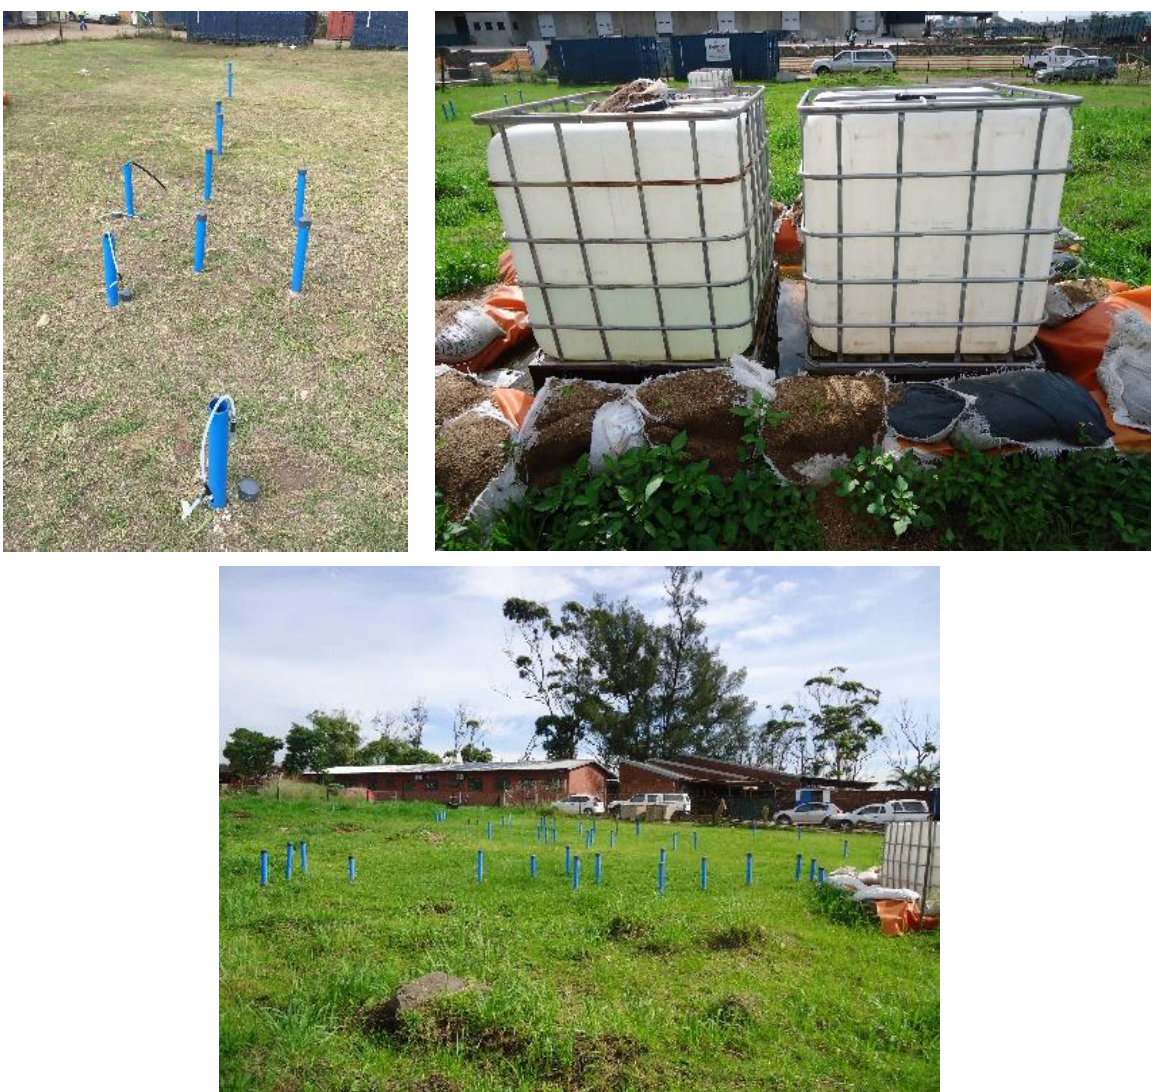
Figure 1. In situ treatment implemented at site A, located in the KwaZulu Natal province of South